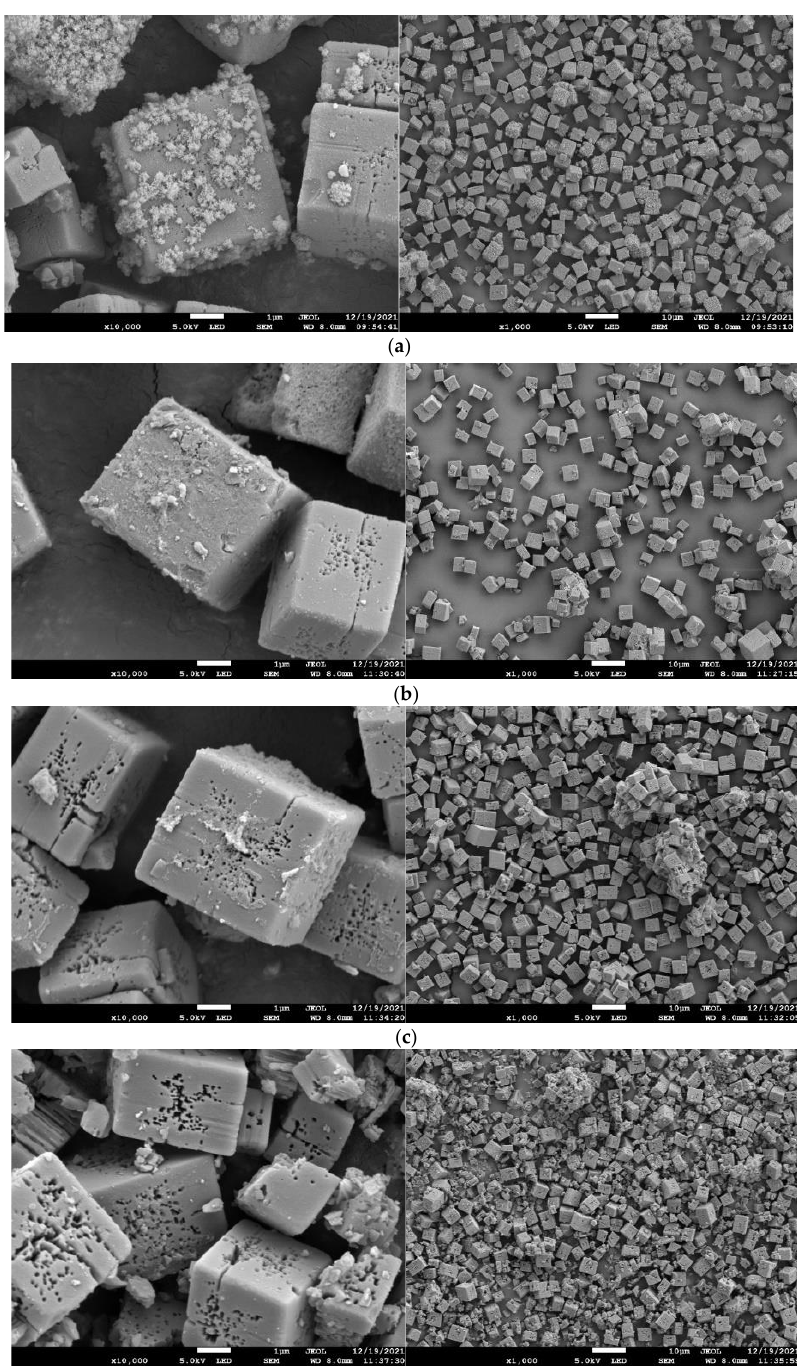
Figure 4. SEM images of 4Cu-4Ce/SAPO-34 ( a ), 4Cu-4Ce-2Zr/SAPO-34 ( b ), 4Cu-4Ce-4Zr/SAPO-34 ( c ), and 4Cu-4Ce-6Zr/SAPO-34 ( d ) (the magnifications is 10,000 and 1000 times).